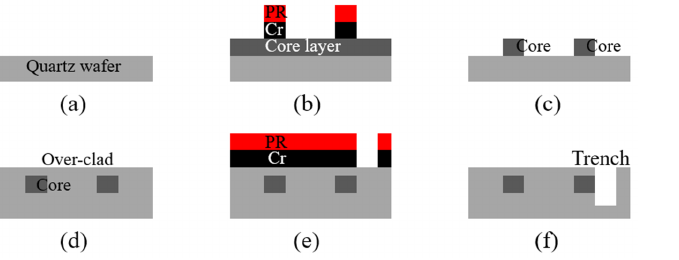
Figure 3. Schematic of the fabrication procedure for the integrated PLC sensor probe device: ( a ) fused-synthesis quartz wafer; ( b ) fabrication of the core structure; ( c ) fabricated core structure; ( d )